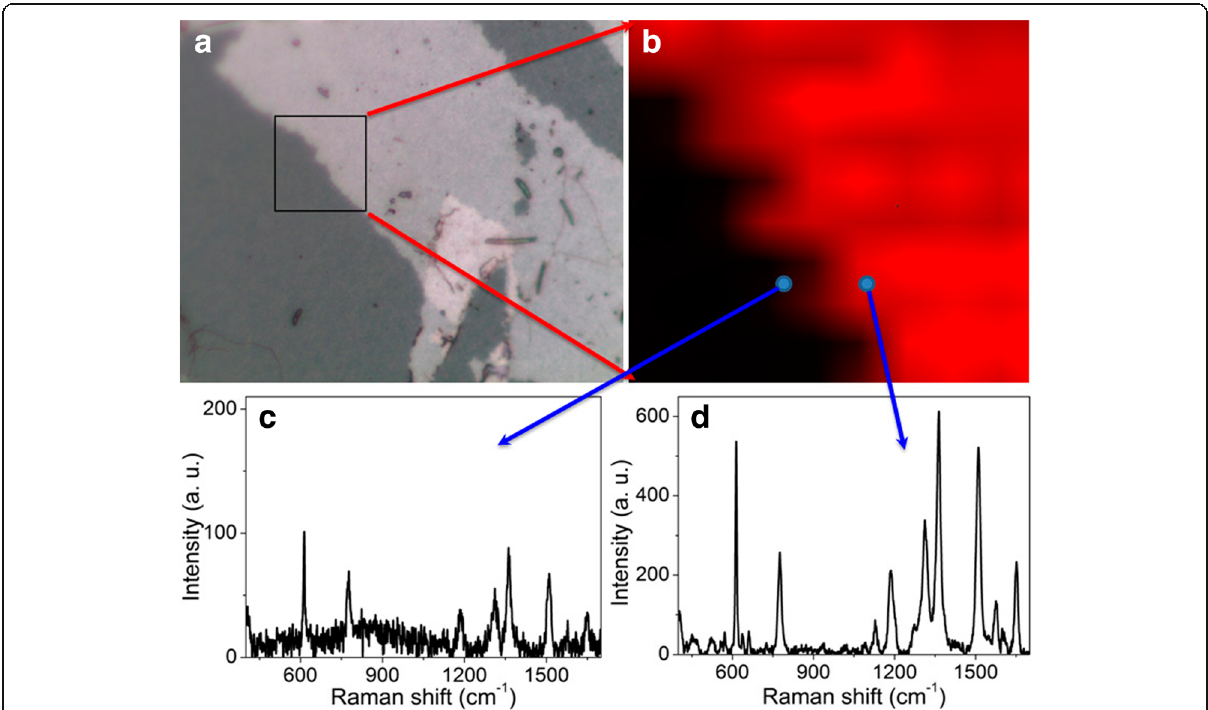
Fig. 11 a Sample image and b SERS mapping taken from the boundary of the fabricated sample with 37.5 s sputtering time of each layer of porous Au films. Raman spectra measured in the single c and dual-layer d porous Au films as marked with the arrows